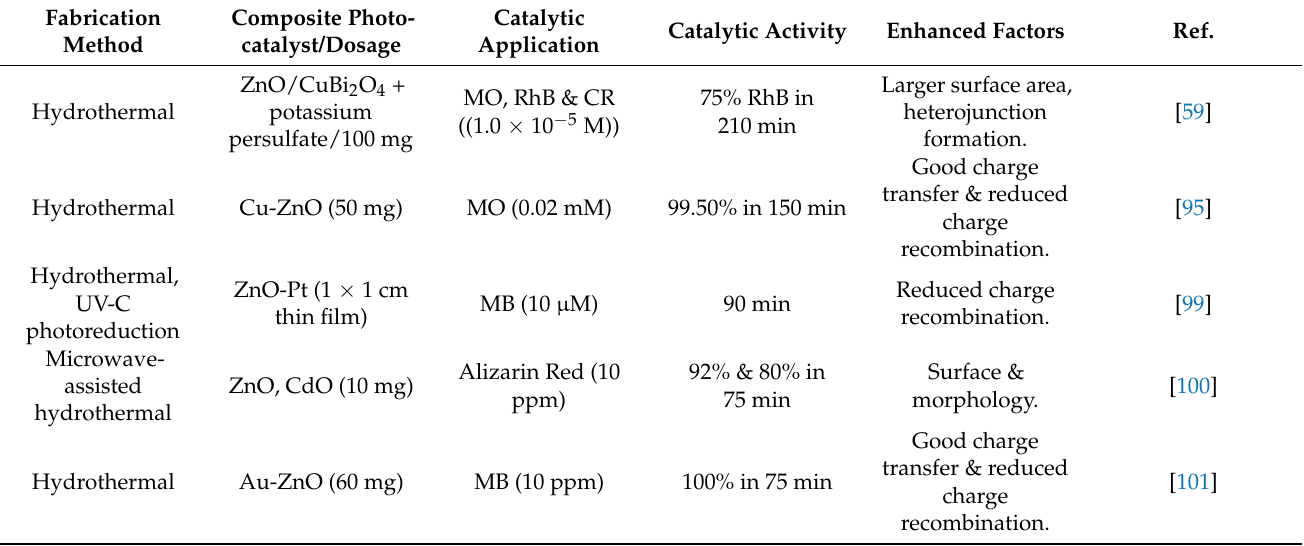
Table 4. ZnO nanostructures prepared by hydrothermal